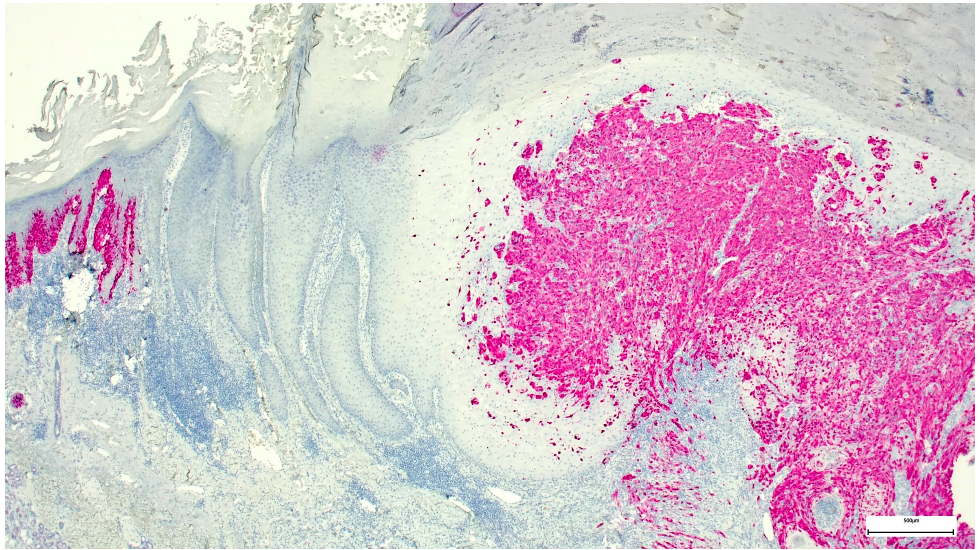
Figure 5. Melan-A immunohistochemical stain highlighting the melanoma component of the collision tumor.